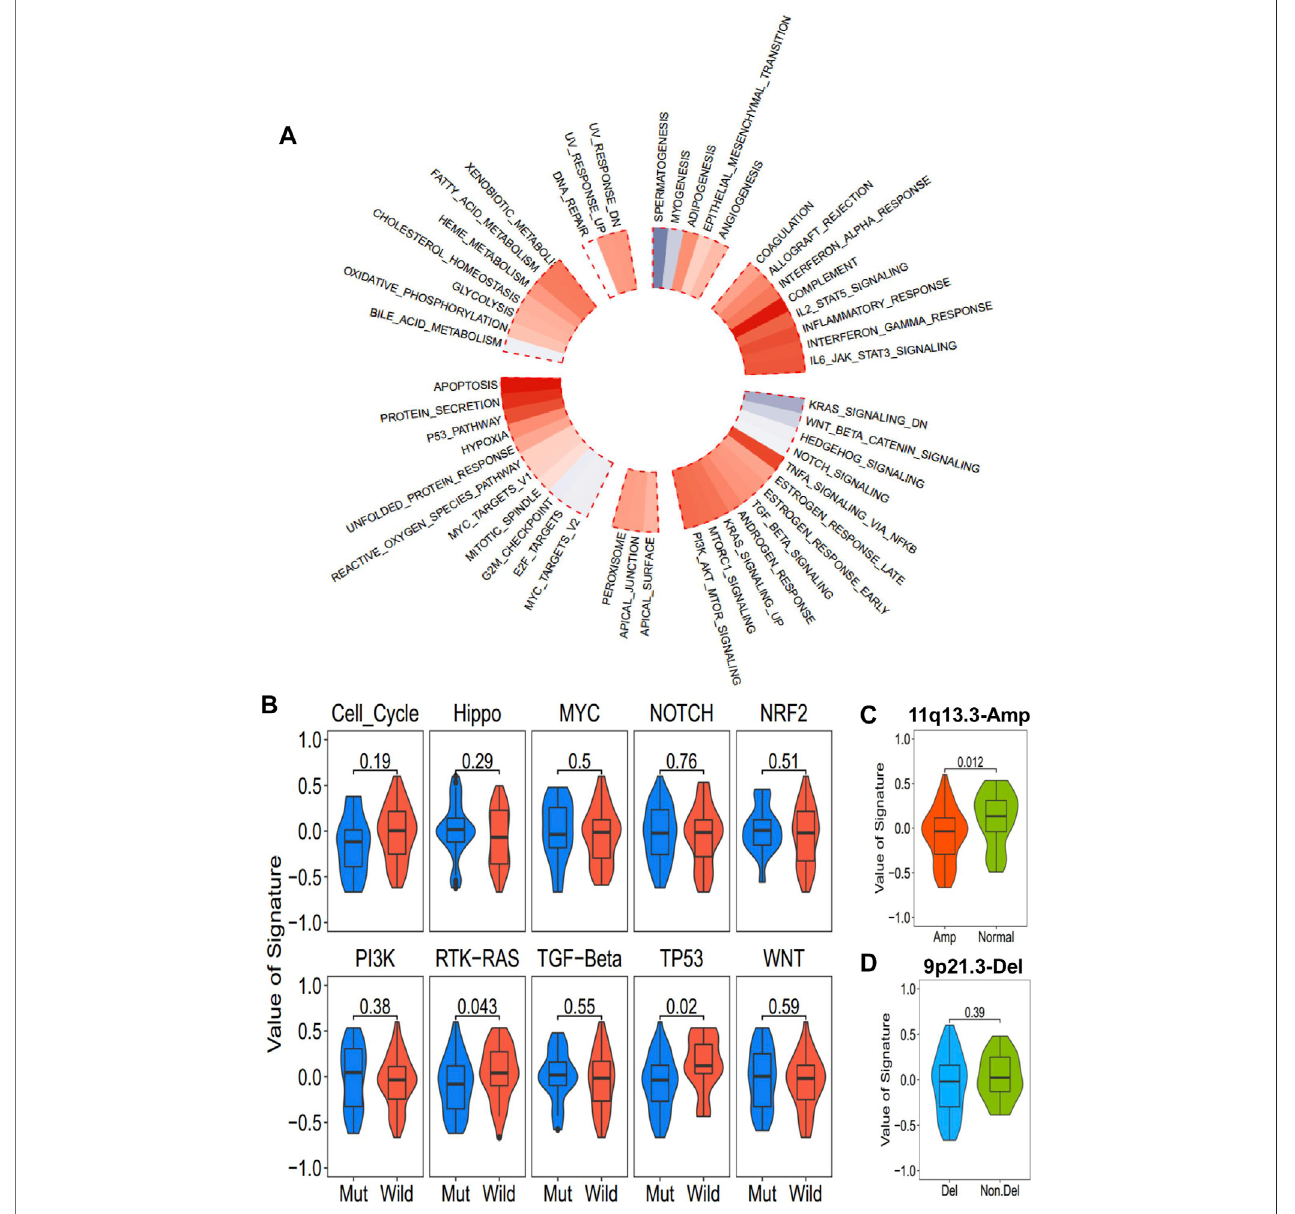
FIGURE 6 | Association between the ICD-score and hallmark pathways. (A) Correlation of the ICD score and hallmark pathways (red for positive correlation; gray for negative correlation). (B) ICD score of mutated and wild-type groups of hallmark pathways in the TCGA-ESCC cohort. (C,D) . ICD score comparison of patients with common copy number alteration in ESCC and normal patients. (C) 11q13.3 ampli fi cation group vs. normal group. (D) 9p21.3 deletion group vs. non-deletion group.